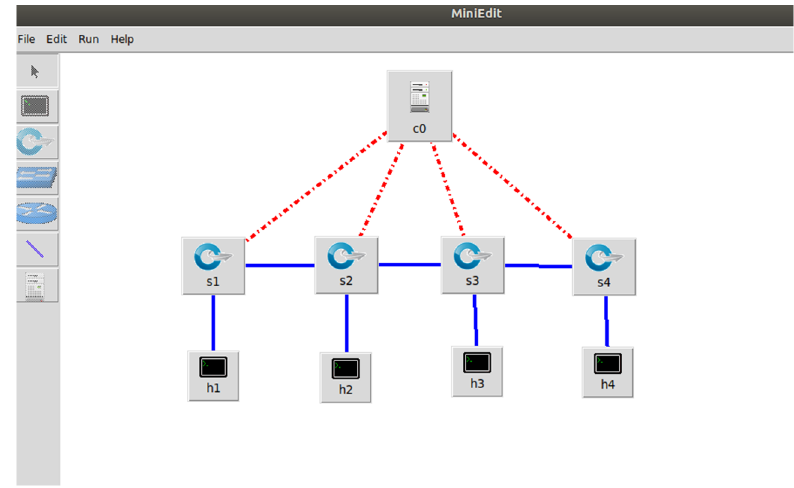
Figure 31. Create Linear topology via miniedit.